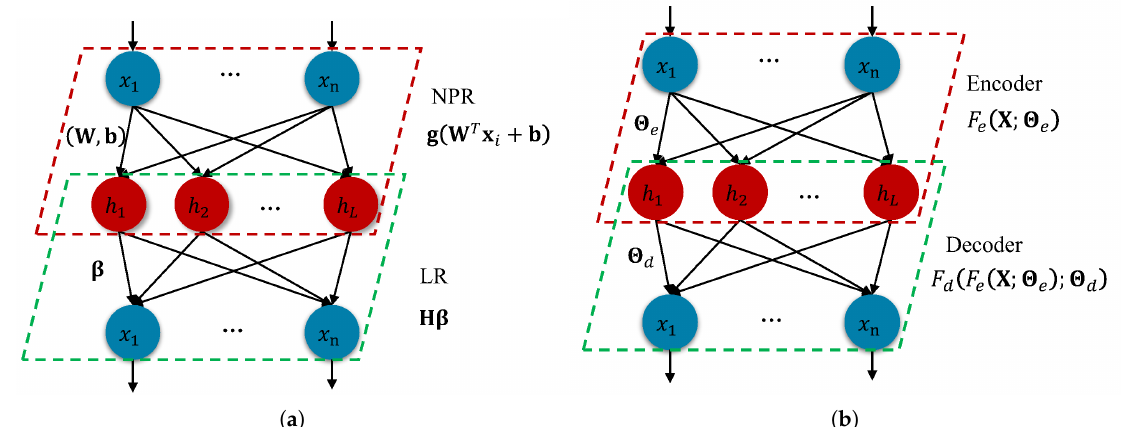
Figure 1. ( a ) ELM-AE includes NPR and LR. Using β T as the transformation matrix to transform features. ( b ) AE consists of an encoder (red rhomboid box) and a decoder (green rhomboid box). The outputs of encoder represent the learned